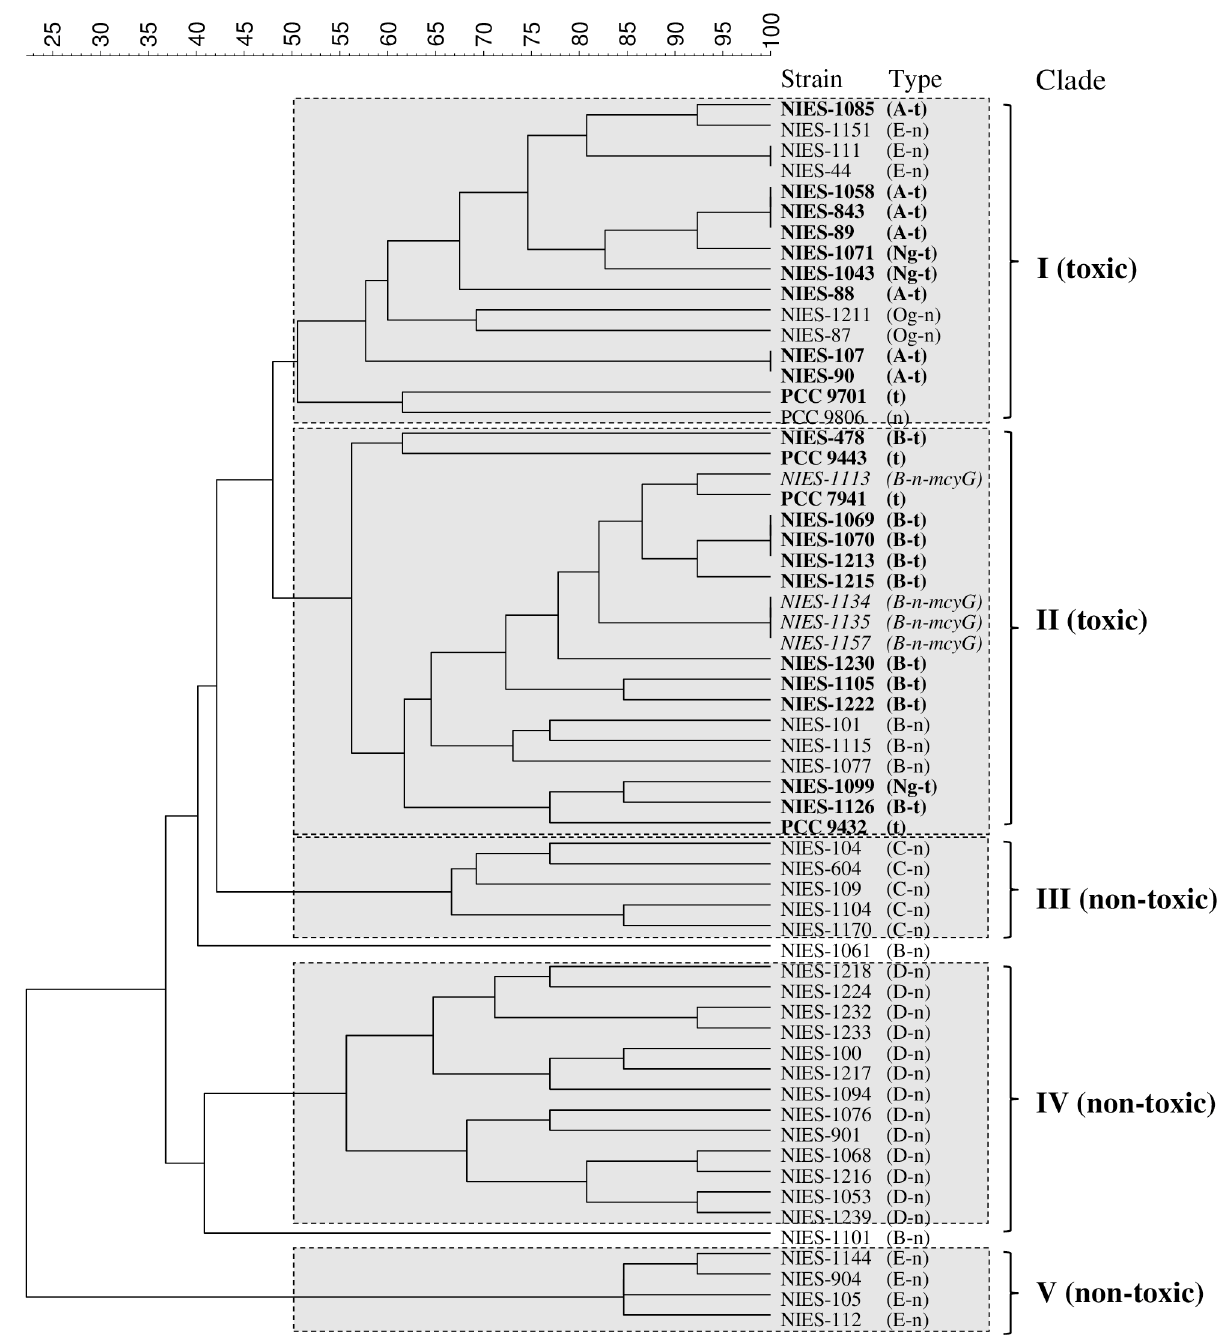
Fig 4. Polygenetic tree of M . aeruginosa strains based on MAIDI-TOF MS ribosomal protein profiling. Strains are labeled and classified by their group and toxicity. The group names indicated in capital letters (A, B, C, D, E) were described by Tanabe (2007) using the MLST method. t: toxic; n: non-toxic; Ng-no group; Og: other group. In addition to the measured strains, 5 sequenced strains (PCC 7941, PCC9432, PCC 9443, PCC 9701, PCC 9806) were employed as references.